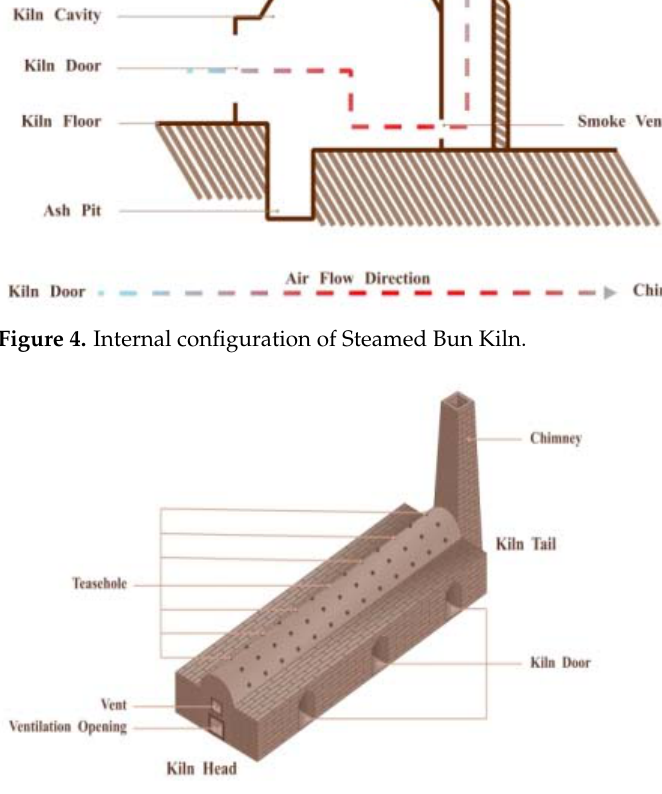
Figure 5. External View of Dragon Kiln.